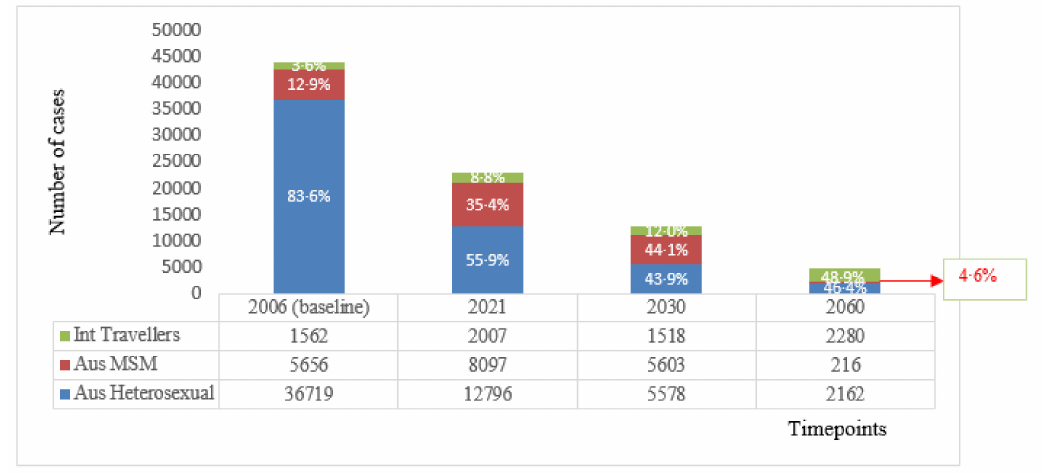
Figure 3. Revised number and proportion of estimated new genital warts cases in Australia for timepoints 2006, 2021, 2030 and 2060, after adjusting for the ongoing transmission due to importation of genital warts, by population